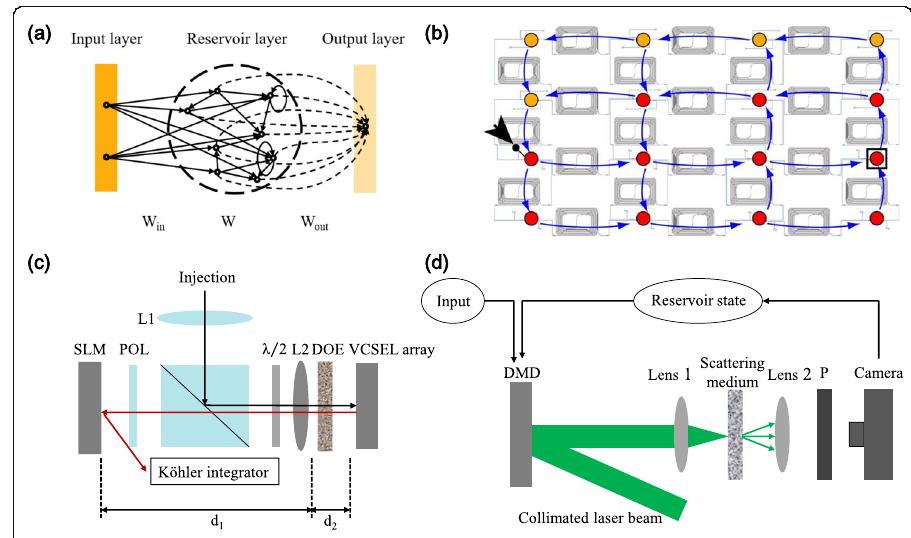
Fig. 3 Layout of standard RC and schemes of Spatially Distributed RC. a Standard layout of a reservoir computer. Solid arrow denotes the weight matrix that is fixed and untrained, while dashed arrow denotes the readout matrix that need to be trained. b Design of the 16-node passive reservoir [72]. c Schematic of the diffractive coupling of an optical array. SLM, spatial light modulator. POL, polarizer. DOE, diffractive- optical element. VCSEL, vertical-cavity surface-emitting laser. d Experimental setup of the